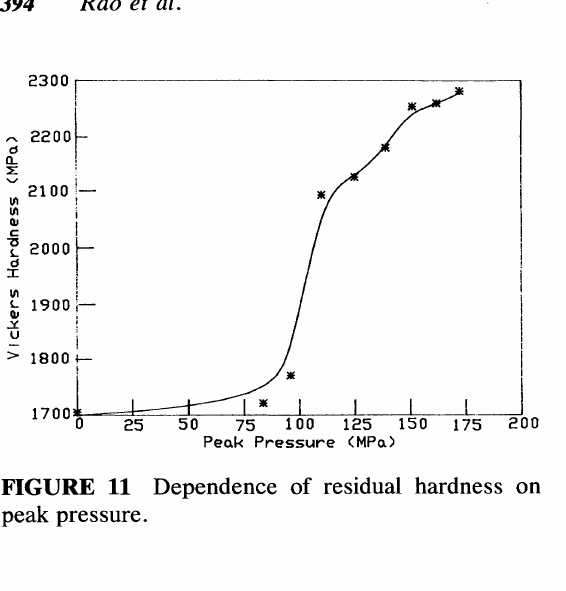
FIGURE 11 Dependence of residual hardness on peak